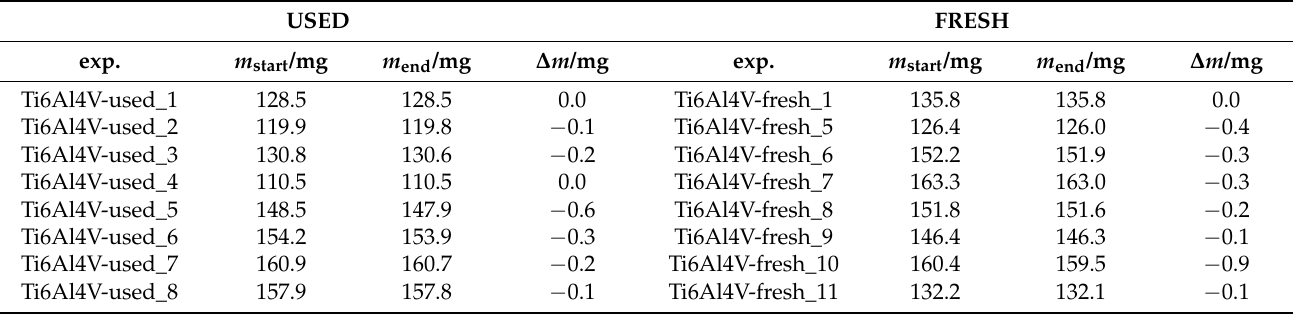
Table A1. List of levitation experiments that were successful and the corresponding mass before and after the experiment. USED FRESH